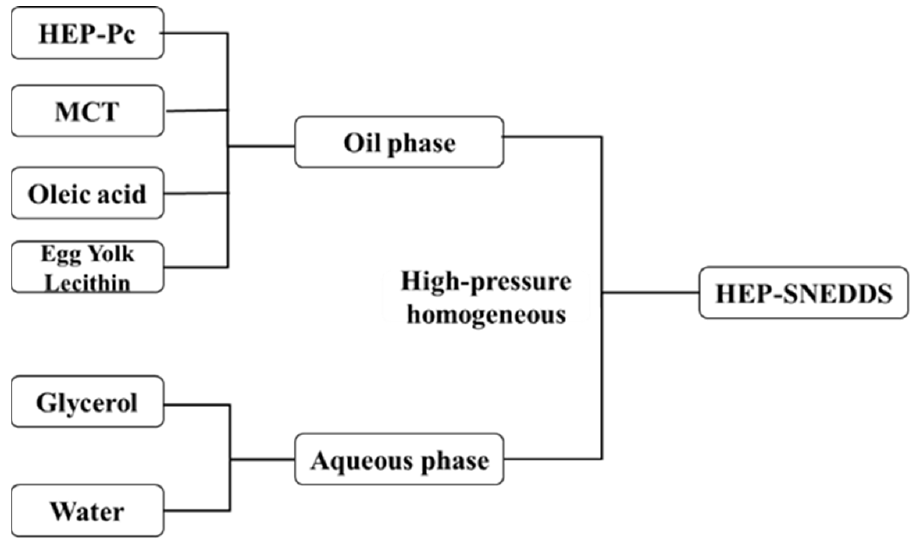
Figure 6. The scheme of the self-nanoemulsifying drug delivery system of heparin (HEP-SNEDDS) preparation.